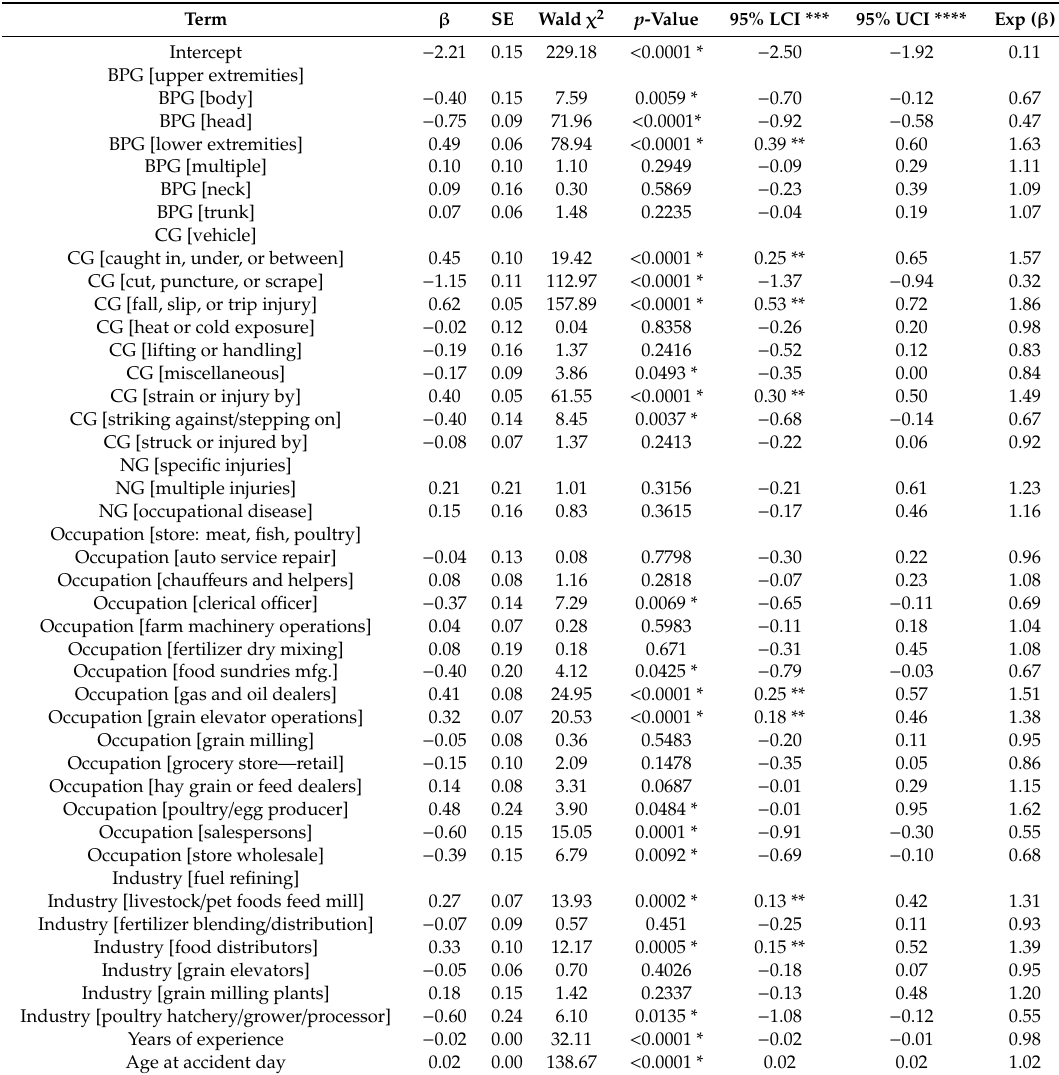
Table 5. Detailed estimates from the LR